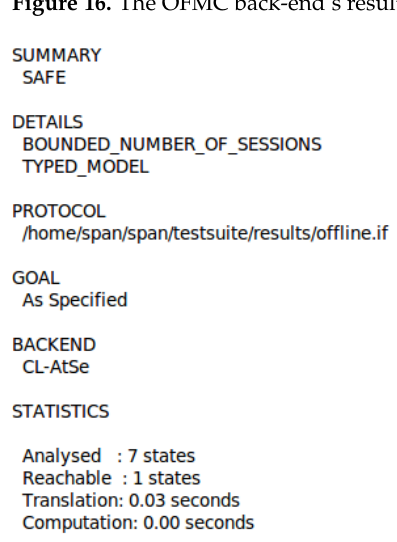
Figure 17. The CL-AtSe back-end’s